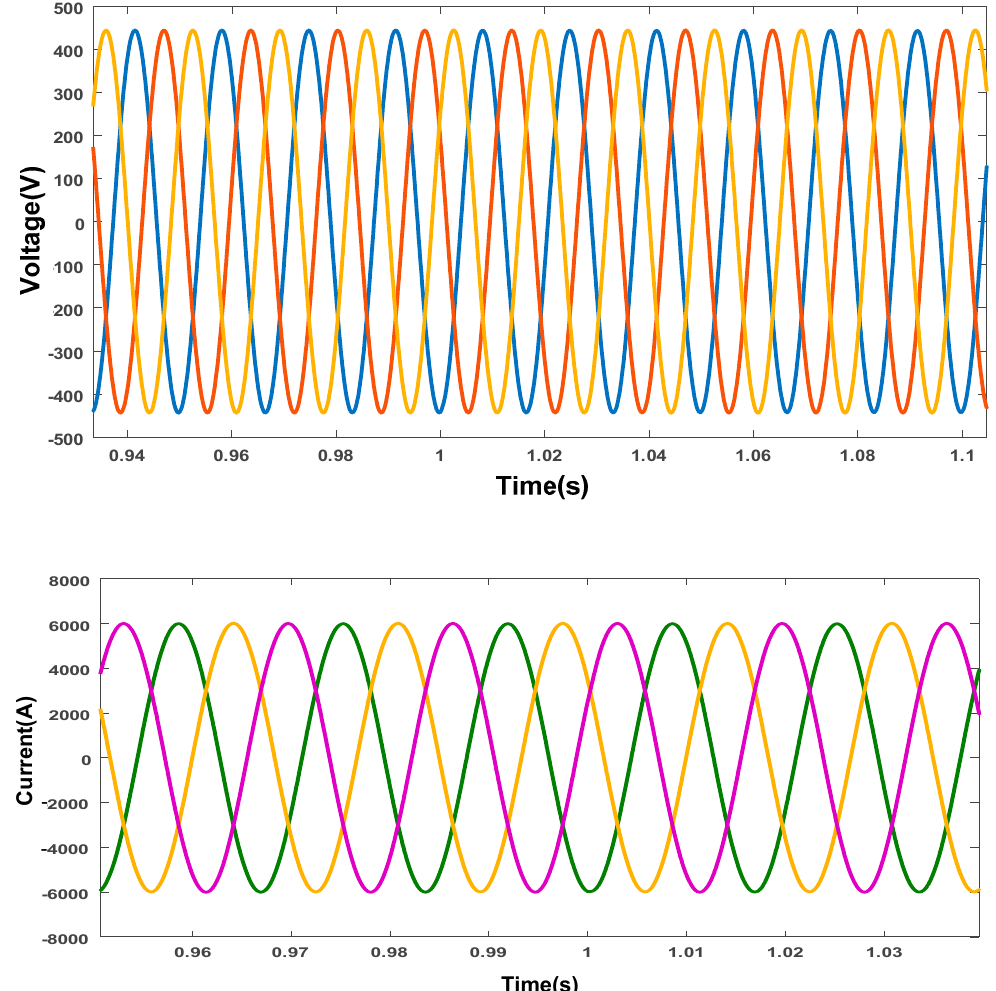
Figure 22. The magnitude voltage and current load with an imbalanced load.